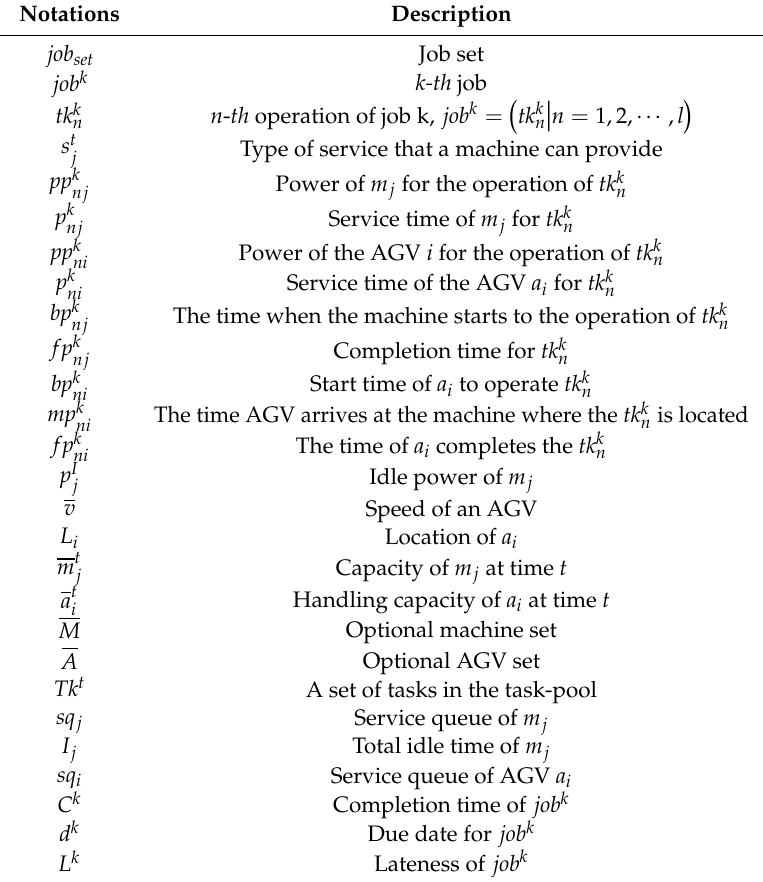
Table 1. The notation used in the